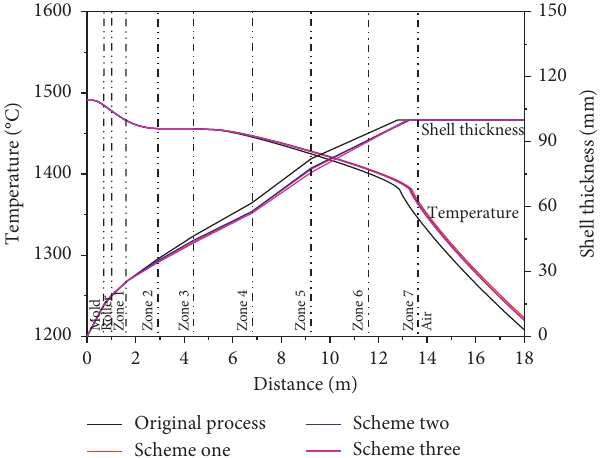
Figure 13: The liquid core length under different water distribution